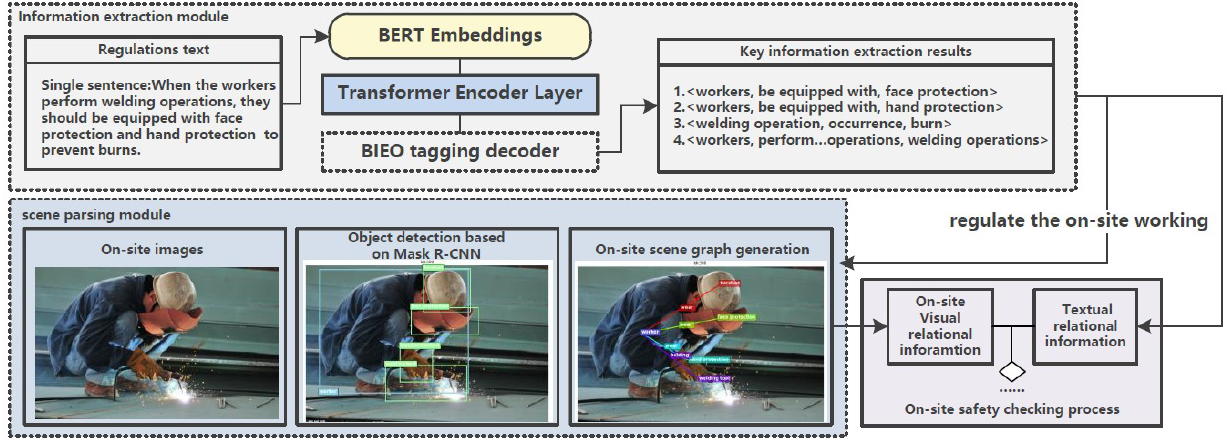
Figure 1. Overall pipeline of the proposed